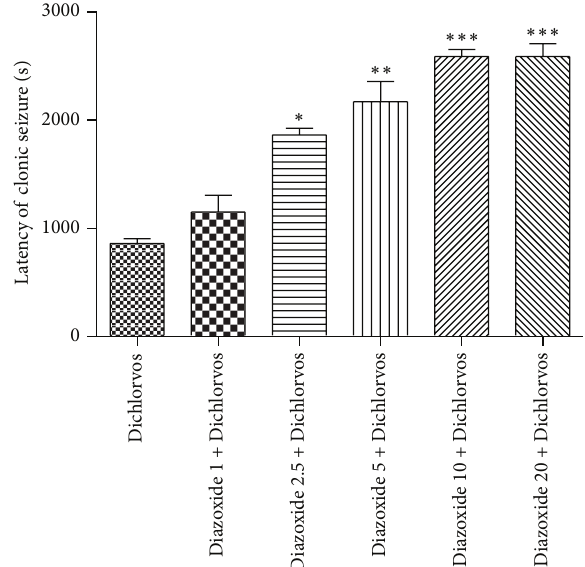
Figure 1: Effect of different doses of Diazoxide (mg/kg) on the start- ing time of clonic seizures after injection of Dichlorvos (50mg/kg) (second). Data are shown as mean ± SEM. ∗ 𝑃 < 0.05 , ∗∗ 𝑃 < 0.01 , and ∗∗∗ 𝑃 < 0.001 compared Dichlorvos group. ( 𝑛 = 10